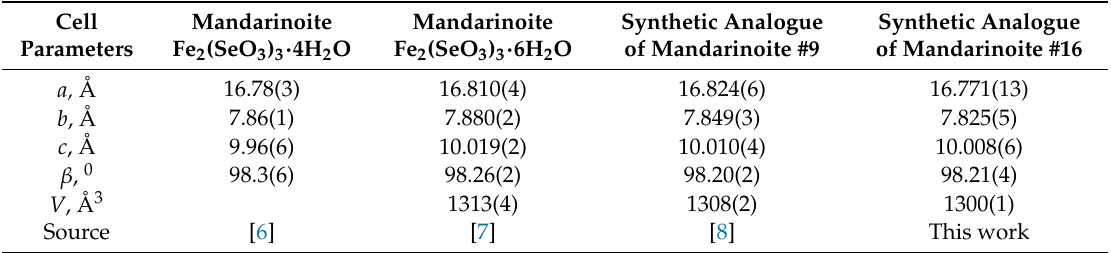
Figure 2. Representative XRD patterns of synthetic analogue of mandarinoite (sample #9; 30 °C, 1.5 bar, 47 days) [8]. The blue bars depict the theoretical XRD reflexes of mandarinoite. Table 2. Cell parameters of mandarinoite (Space group P2 1 /c).